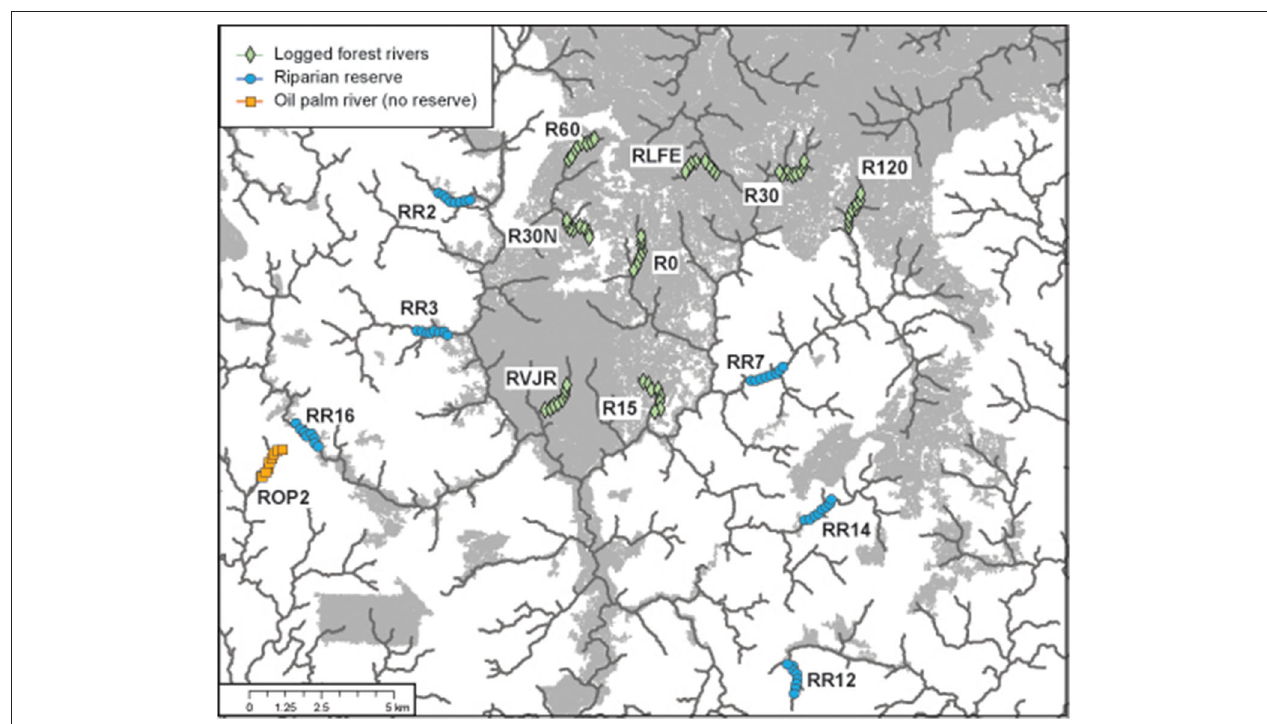
FIGURE 1 | Location of the 15 rivers sampled for bats via acoustic monitoring in the Stability of Altered Forest Ecosystems (SAFE) landscape of Sabah, Malaysian Borneo. Each site comprised eight recording points, which were sampled multiple times. Forested area in gray (derived from Hansen et al., 2013 data for 2014); oil palm estates in white. Lines denote the river